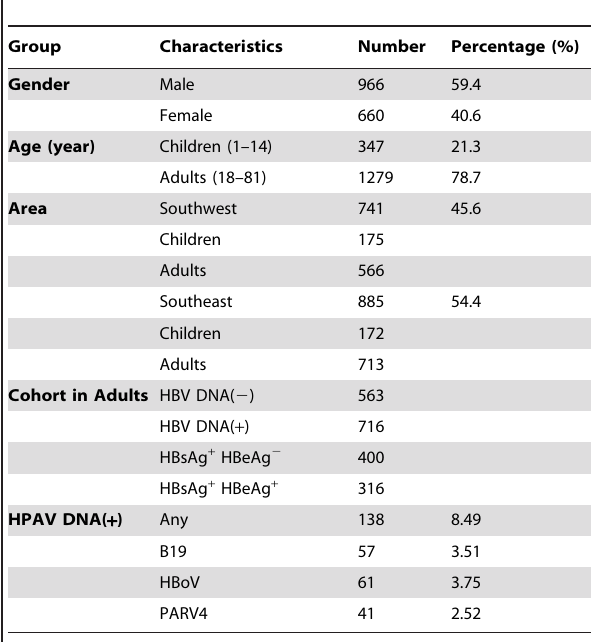
Table 2. Prevalences of B19, HBoV and PARV4 in different age, gender, and regional